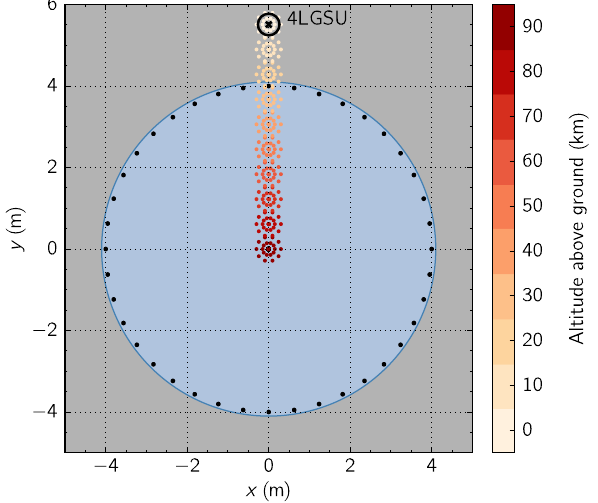
11. Sampling of the primary mirror plane in our 4 LGSF þ UT 4 model, resulting in the sampling of the reconstructed laser beam images shown in Fig. 10. For clarity, the mirror is only sampled using its center and 60 locations on its outer